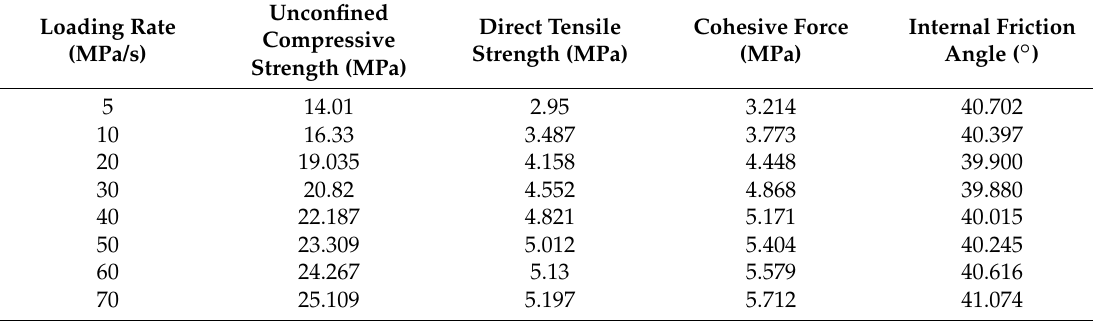
Table 8. Cohesive force and internal friction angles at different loading velocities.